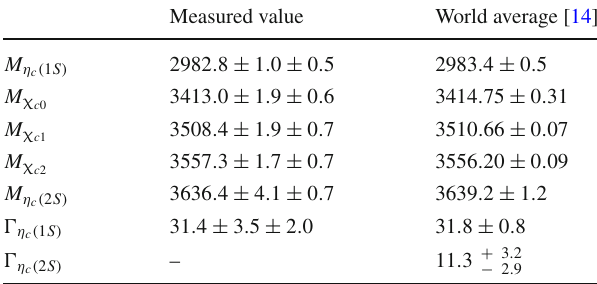
Table 5 Charmonium masses and natural widths in MeV Measured value